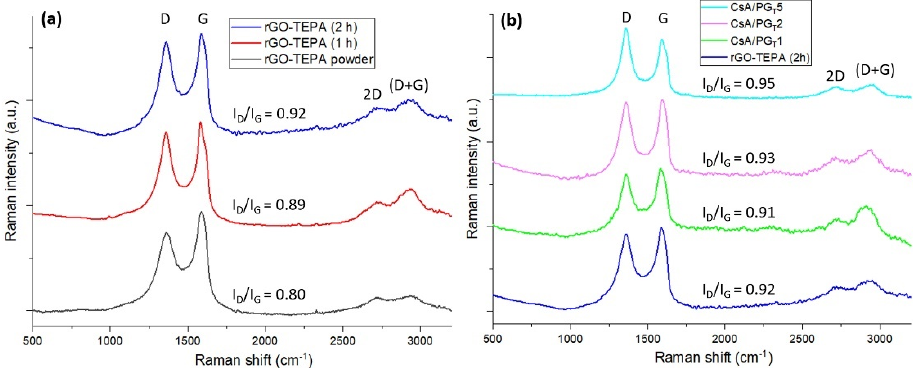
Figure 5. Raman spectra of ( a ) rGO-TEPA powder and after different ultrasonication times, and ( b ) CsA/PG T composite nanofibrous membranes with various rGO-TEPA